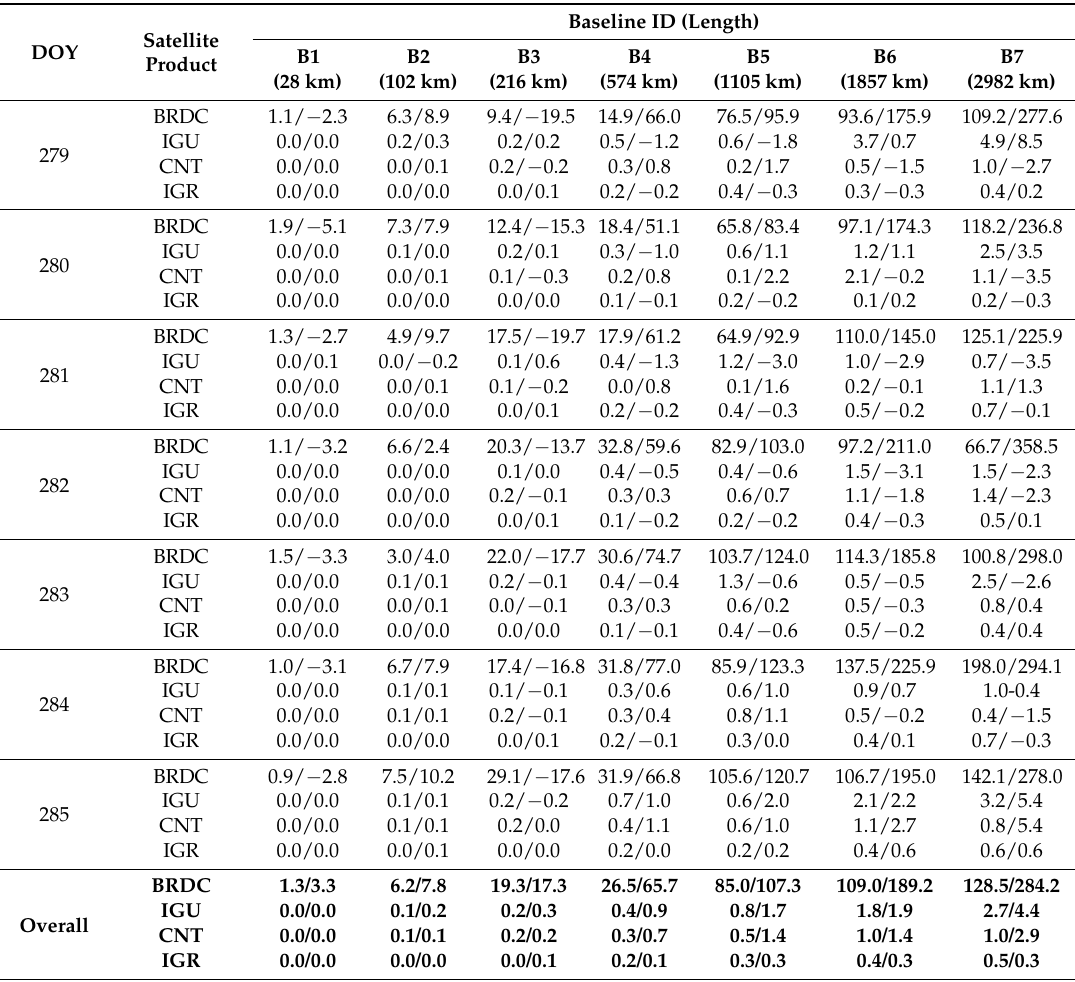
Table 5. Horizontal/vertical relative positioning errors (mm) in PS #3 over the period from DOY 2013 279 to